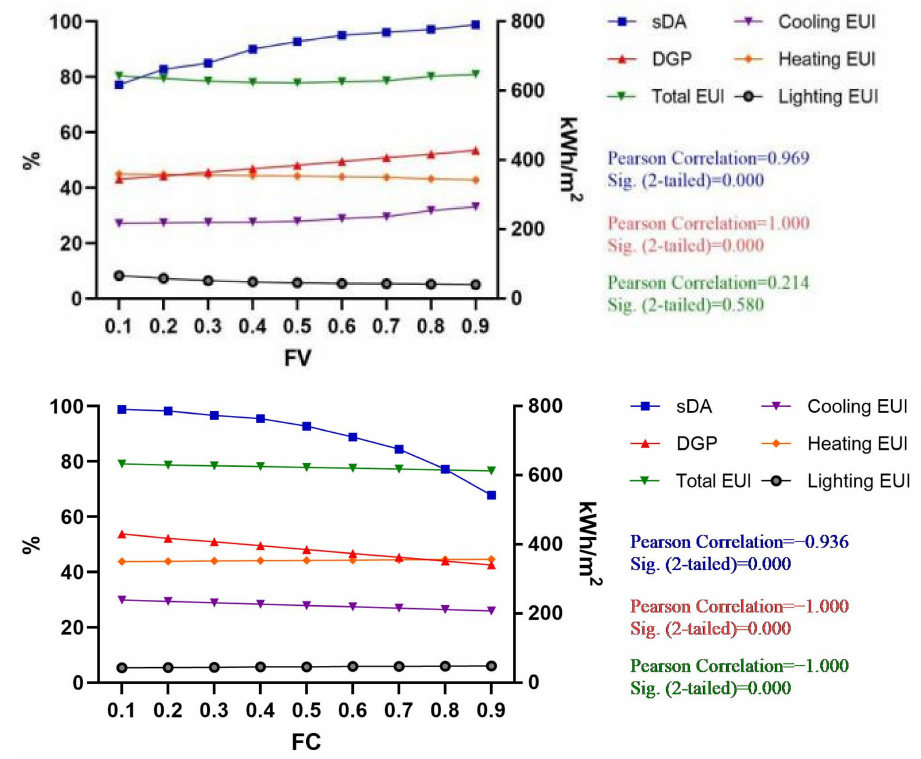
Figure 14. Simulation results of fabric